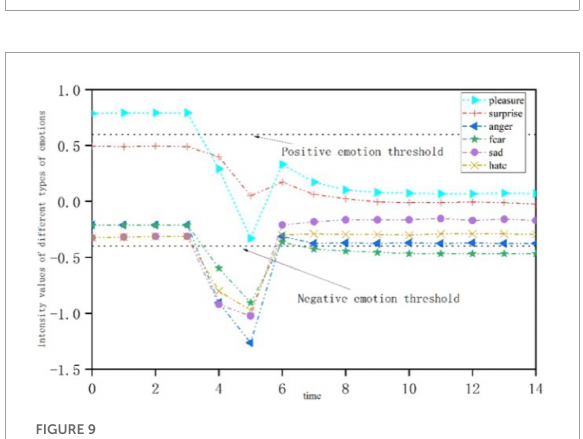
FIGURE6 Emotional change process of open personality stimulated by a single positive stress event.